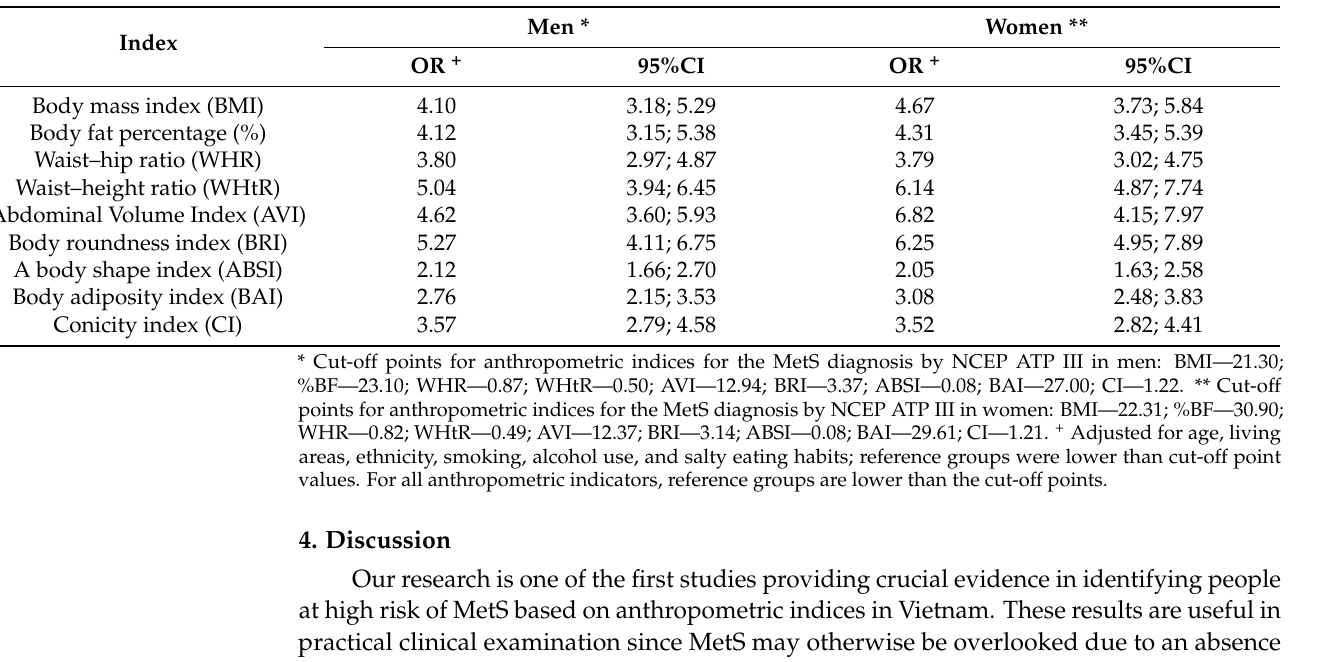
Table 5. Relationship between the anthropometric indices with metabolic abnormalities in multivari- ate